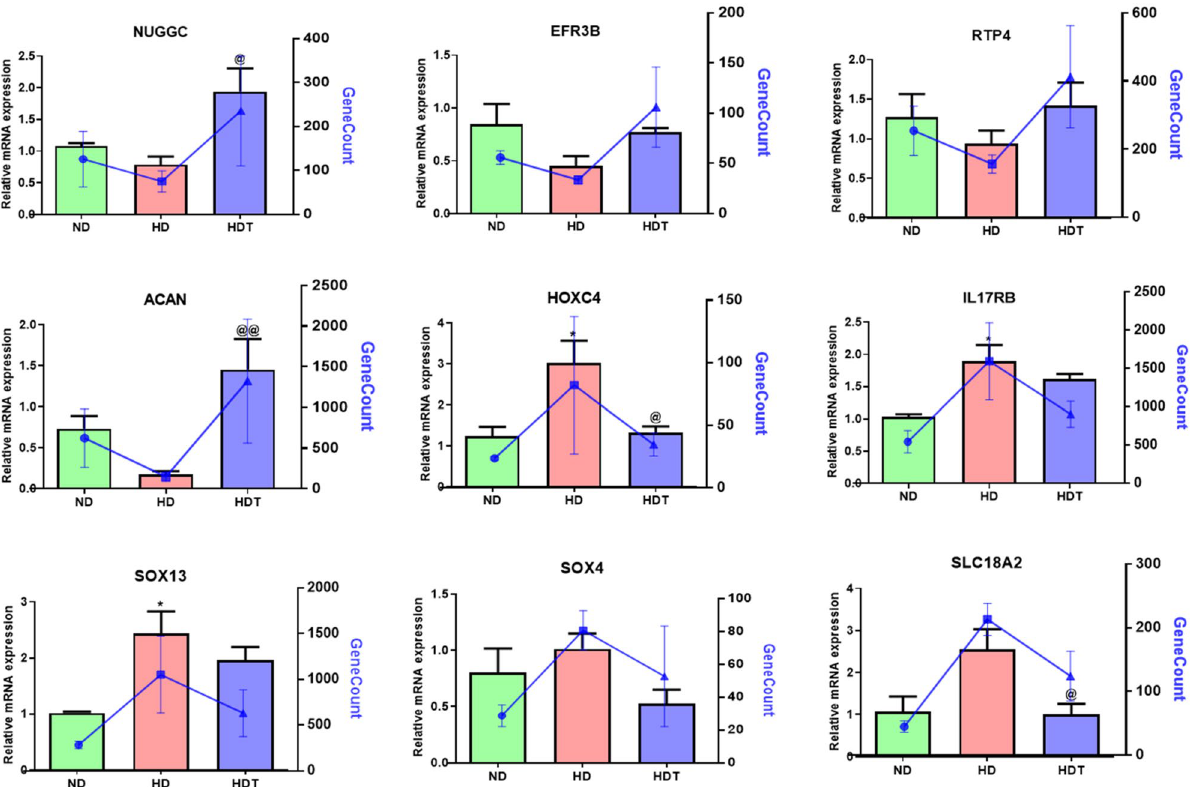
Figure 5. Quantitative expressions of obesity-related genes between the ND, HD, and HDT groups. * p < 0.05 vs. ND. @ p < 0.05, @@ p < 0.01 vs. HD. ND normal diet group, HD high energy intake group, HDT high energy intake with BG&SW supplements treatment group. The blue lines expressed GeneCounts between